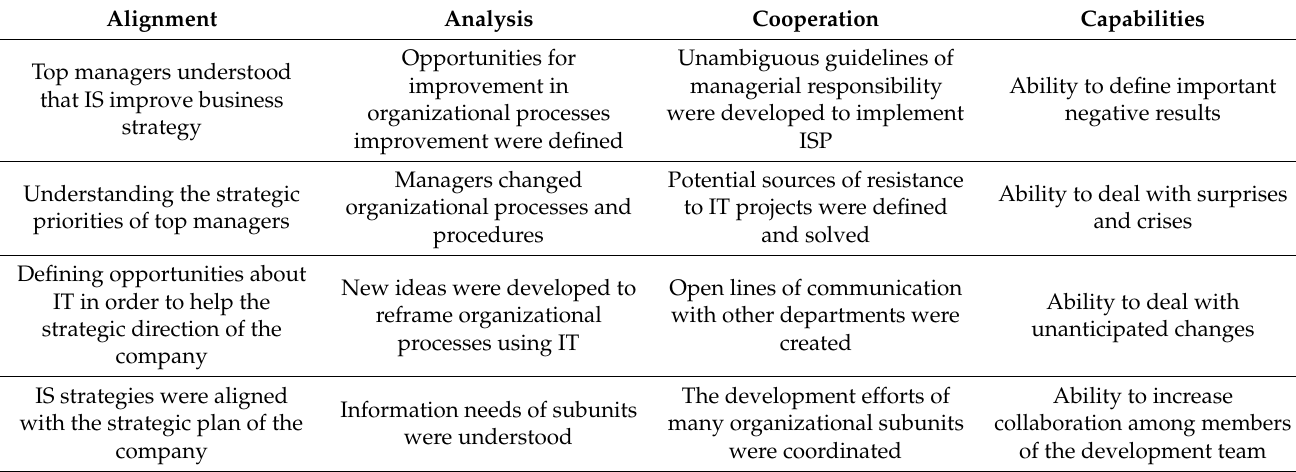
Table A2. Success dimensions and